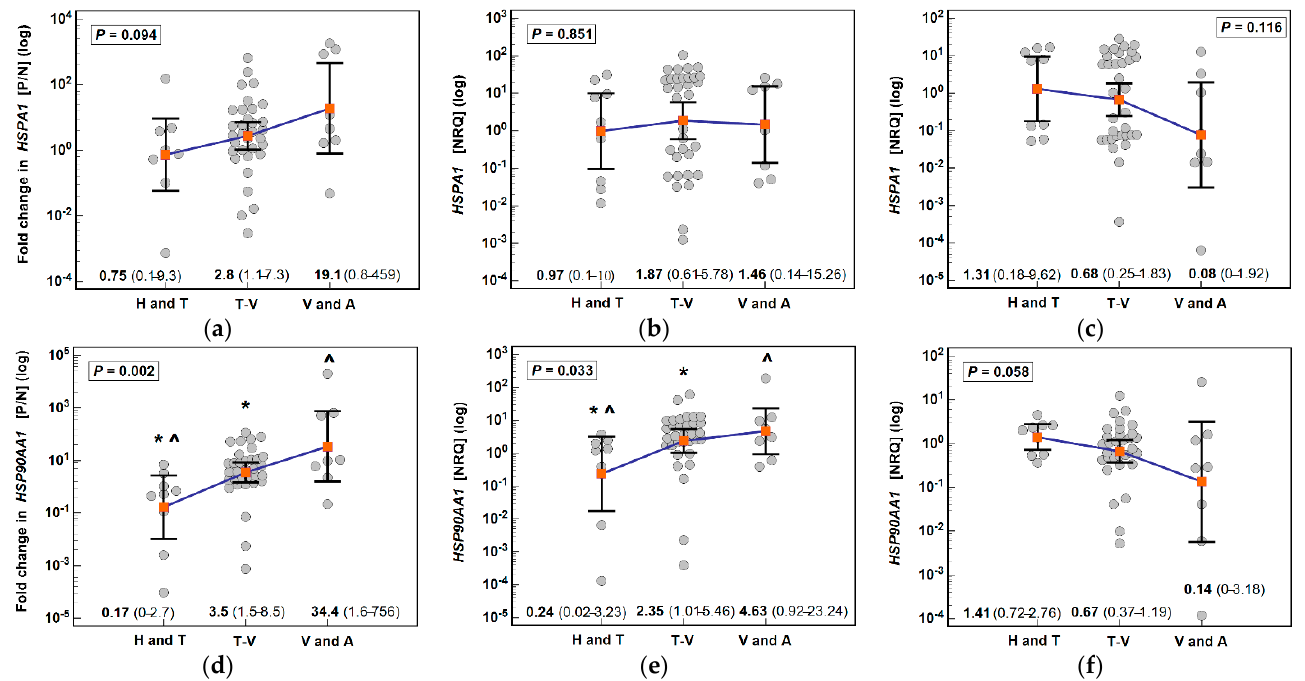
Figure 2. Association of HSP expression with polyp type: ( a ) fold change in HSPA1 expression; ( b ) HSPA1 expression in polyps; ( c ) HSPA1 expression in polyp-adjacent (normal) tissue; ( d ) fold change in HSP90AA1 expression; ( e ) HSP90AA1 expression in polyps; ( f ) HSP90AA1 expression in polyp-adjacent (normal) tissue. Data presented on logarithmic scale as geometric means (red close squares) with 95% confidence interval (whiskers) and analyzed with one-way ANOVA. Groups differing significantly ( p < 0.05) in a post-hoc analysis (Students-Neuman-Keuls test) were indicated by symbols of the same type (* or ^). P/N, polyp-to-normal ratio; NRQ, normalized relative quantity; H, hyperplastic polyps; T, tubular adenomas;